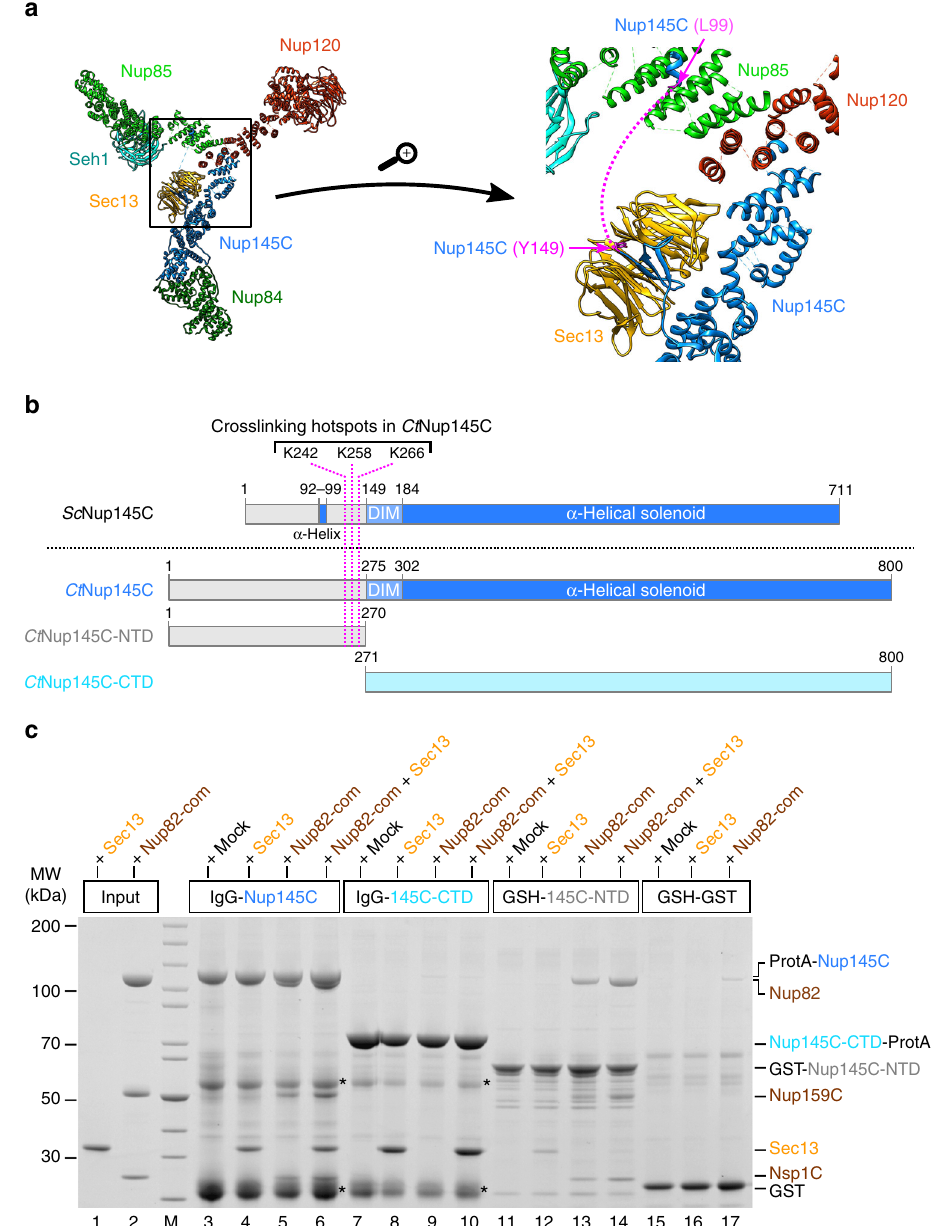
Fig. 2 The N-terminal domain (NTD) of Ct Nup145C is both necessary and suf fi cient for the recruitment of the Ct Nup82 complex. a Crystal structure of the majority of the Y-shaped Sc Nup84 complex (PDB ID: 4xmm). The region upstream of the Sc Nup145C-DIM domain is indicated by a dashed pink line (right panel) as it is missing from the crystal structure. b Schematic representation of Sc Nup145C and Ct Nup145C and the design of truncated Ct Nup145C-NTD and Ct Nup145C-CTD; see also Supplementary Fig. 2. The crosslinking hotspots found in Ct Nup145C-NTD (Fig. 1b) are indicated by dashed pink lines. DIM domain invasion motif. c In vitro binding assay with immobilized Ct Nup145C, Ct Nup145C-NTD, or Ct Nup145C-CTD and soluble Ct Sec13 and/or the Ct Nup82 – Nup159C – Nsp1C complex (Nup82-com). Shown is the analysis of SDS eluates by SDS-PAGE and coomassie staining. The experiment was performed at least twice with consistent results. Asterisks indicate bands corresponding to IgG heavy and light chains; M marker, Mock puri fi cation buffer with E. coli whole cell lysate, MW molecular weight. An uncropped image of the gel is shown in Supplementary Fig.